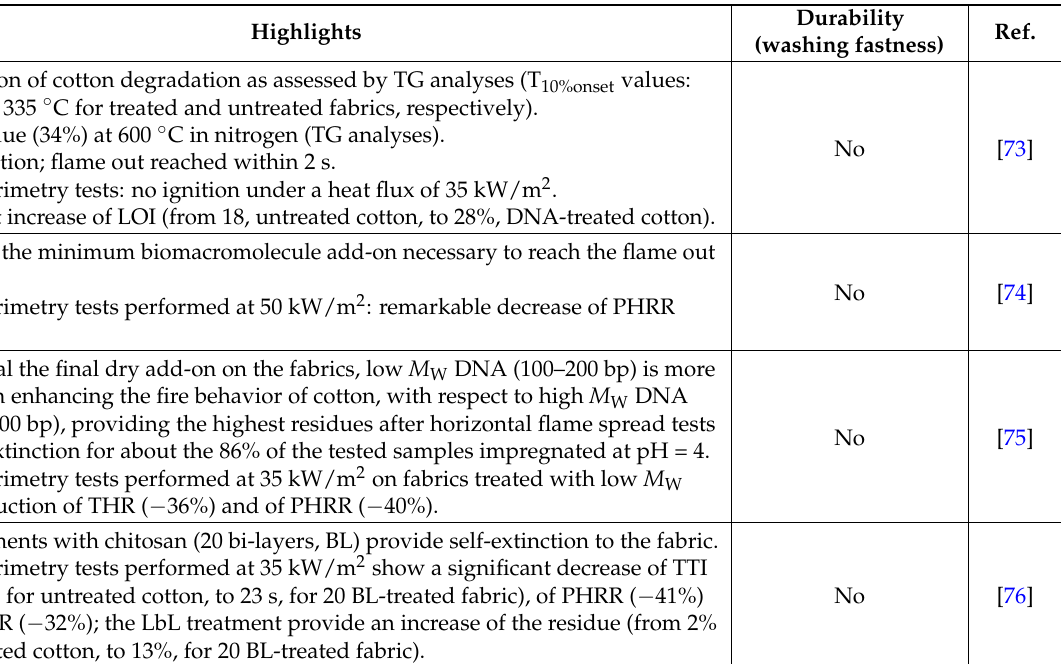
Type of P-based FR Textile material Highlights